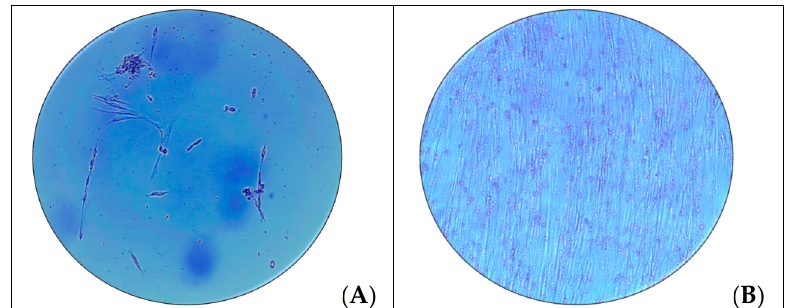
Figure 2. Morphology of swine Swine Dental Pulp Stem Cells (Swine DPSCs) on culture flask. On days 4 to 6 fusiform shape fibroblast-like cells were observed ( A ). On day 21 a 70–80% confluence was reached ( B ). Both images were taken in an inverted light-field phase contrast optical microscope at 10× magnification